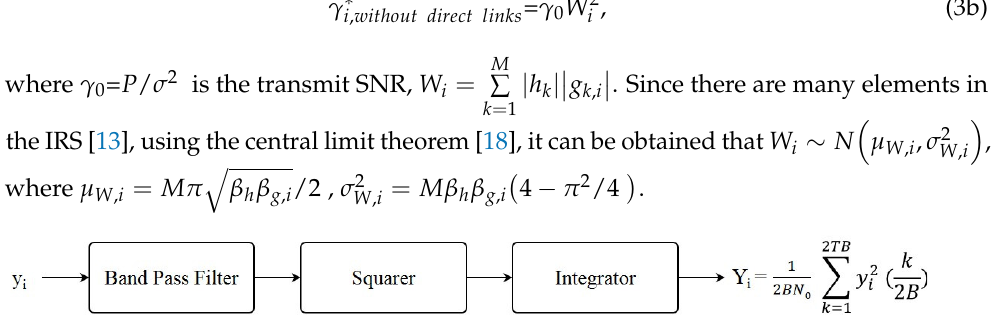
Figure 2. The energy detection